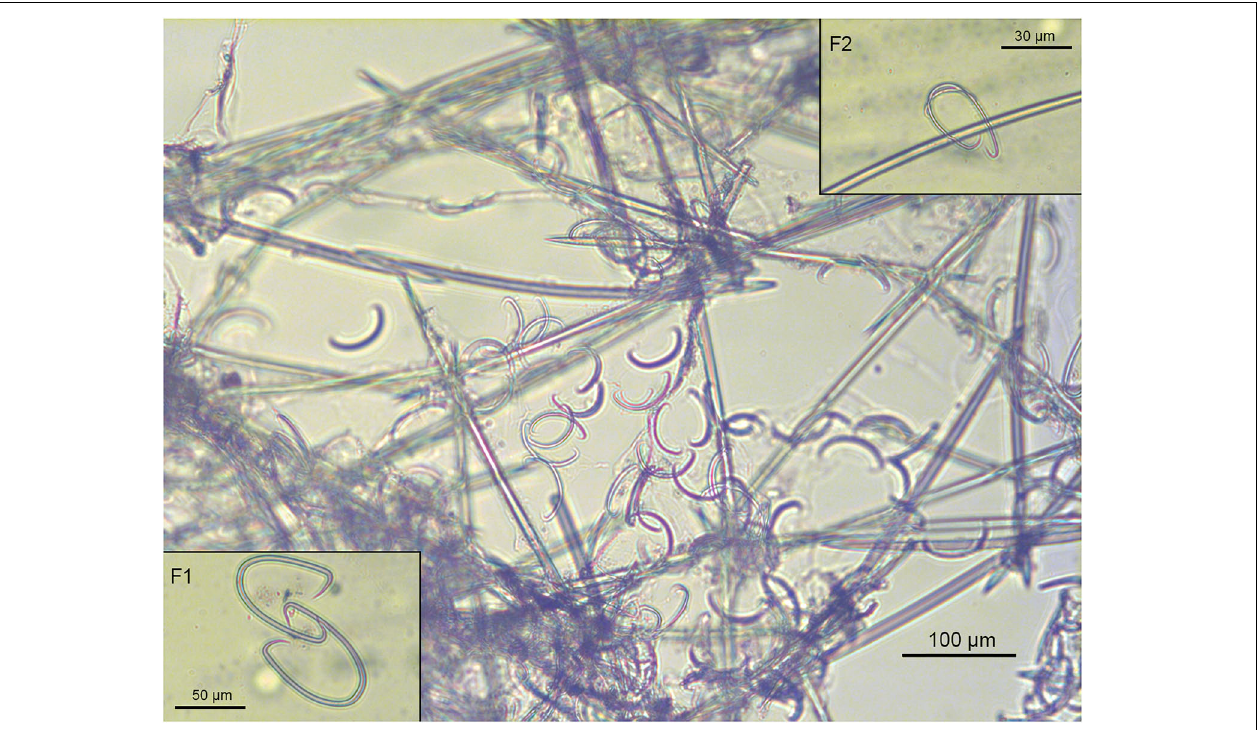
FIGURE 4 | Haliclona ( Flagellia ) hiberniae spicular set and skeletal arrangement as seen with an optical microscope. The skeleton is formed by paucispiculated tracts of oxeas, with abundant sigmas and flagelosigmas (F1 and F2), both in two categories. Scale bars: General, 100 µ m; F1, 30 µ m and F2, 50 µ m.